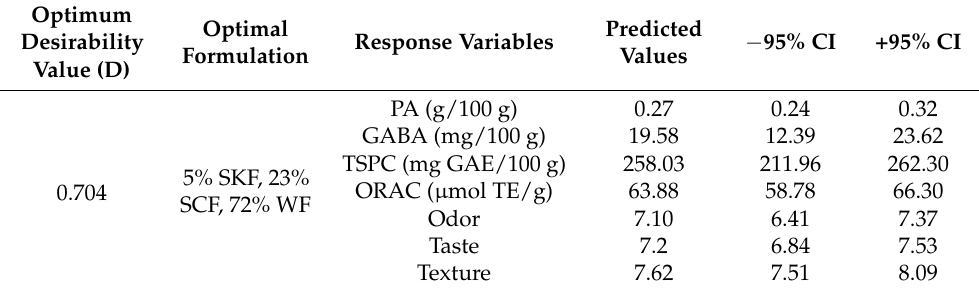
Table 5. Composition of flour blends and predicted values for PA, GABA, TSPC and ORAC in breads at optimum desirability value